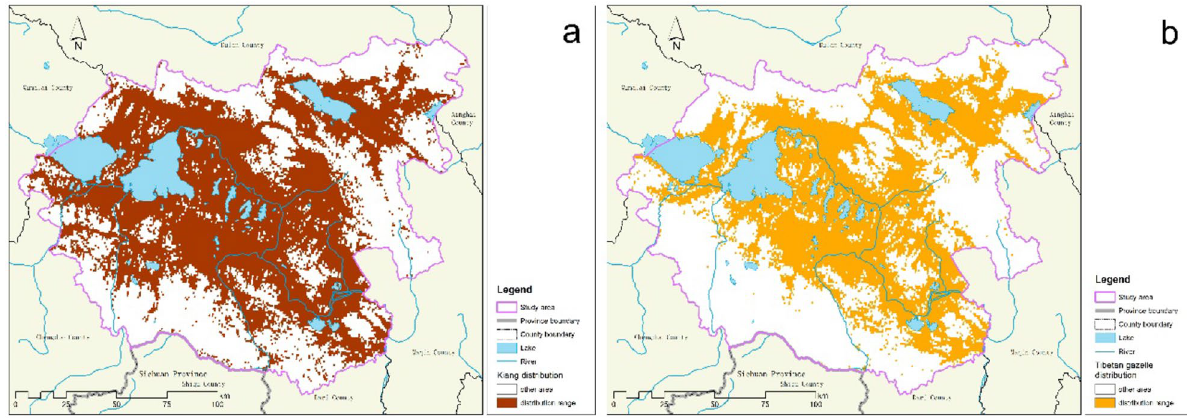
Figure 2. The distribution ranges of kiangs ( a ) and Tibetan gazelles ( b ) in Maduo County. The map was generated using ArcGIS 10.2, https ://deskt op.arcgi s.com/en/.